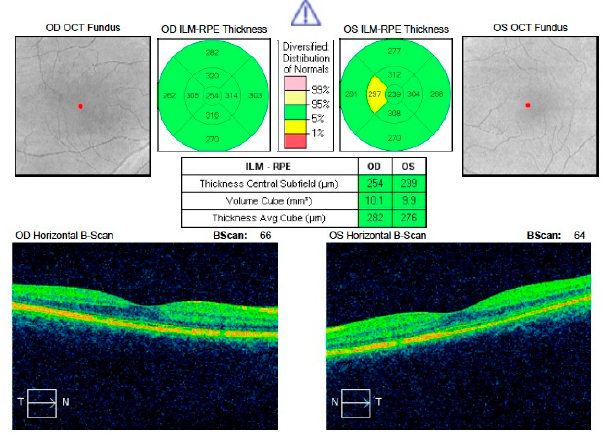
Figure 1. Comparison of CRT in resolved acute central serous chorioretinopathy (CSCR) of the left eye with healthy right eye. Visible reduction in CRT in the left eye. SD OCT: spectral-domain optical coherence tomography; RPE: retinal pigment epithelium; OS—left eye; OD—right eye; OCT—optical coherence tomography; ILM-RPE—internal limiting membrane—retinal pigment